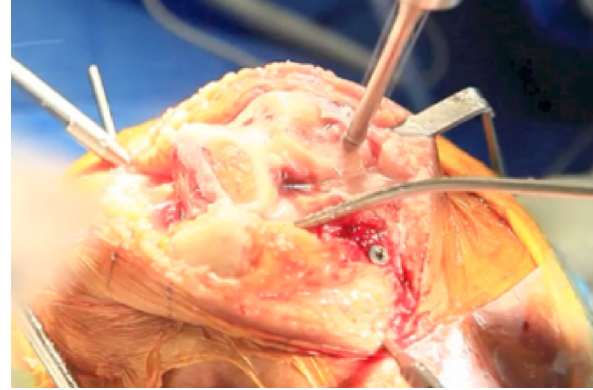
Figure 4. Digitization of femoral